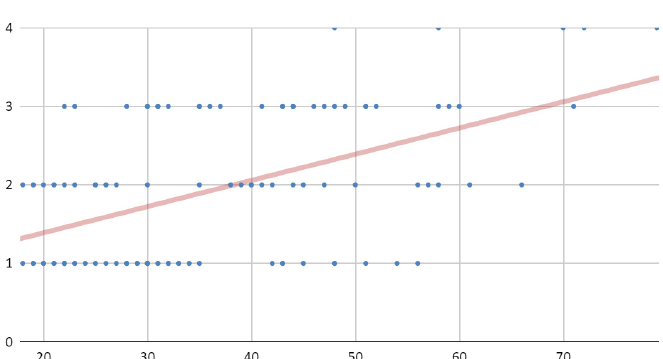
Figure 5. The correlation between the age of the patients and their dental condition. Description in the text.